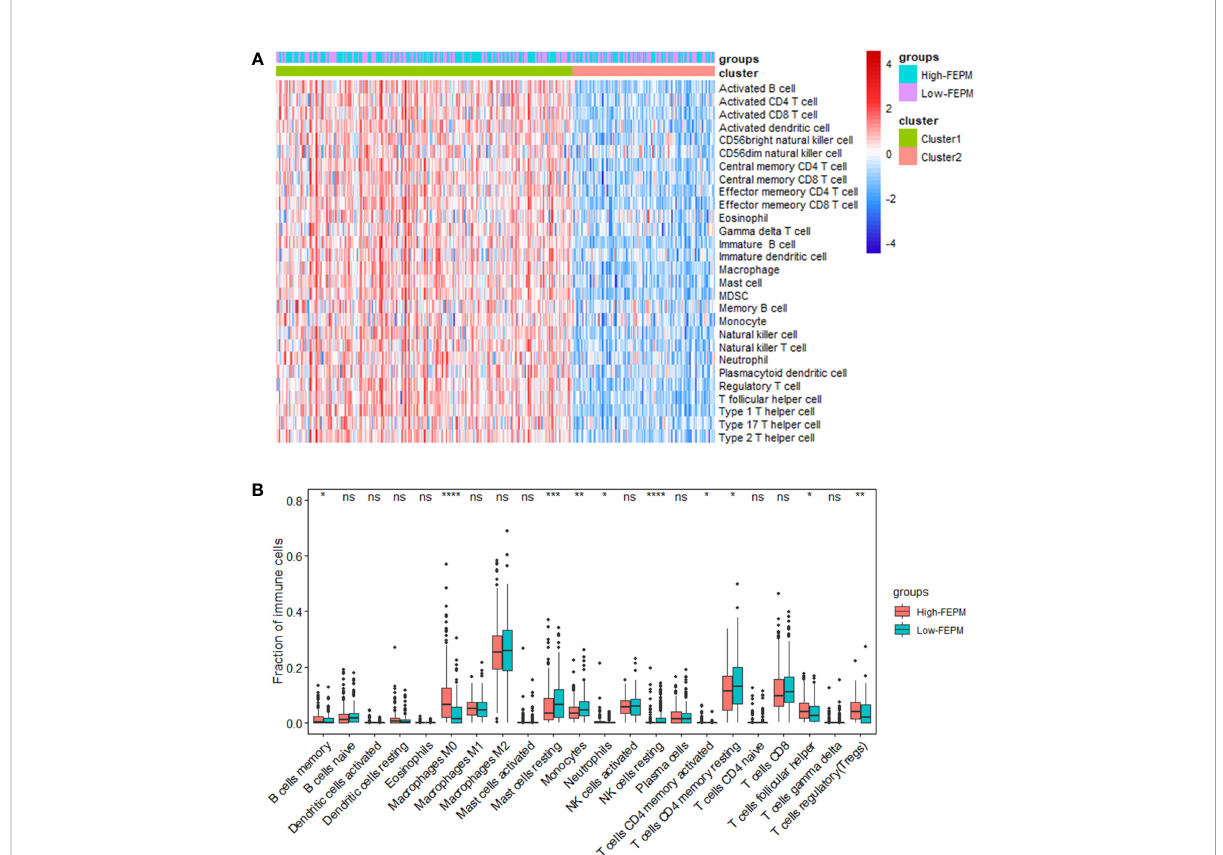
FIGURE 7 Analysis of tumor immune microenvironment. (A) A heatmap of ssGSEA in the TCGA cohort showing the high immune in fi ltration cluster (cluster 1) and the low immune in fi ltration cluster (cluster 2). (B) Comparison between the fractions of immune cells in the high-FEPM and low- FEPM groups of the TCGA cohort via the CIBERSORT method. * p< 0.05; **p< 0.01; ***p< 0.001; ****p< 0.0001; ns, not signi fi